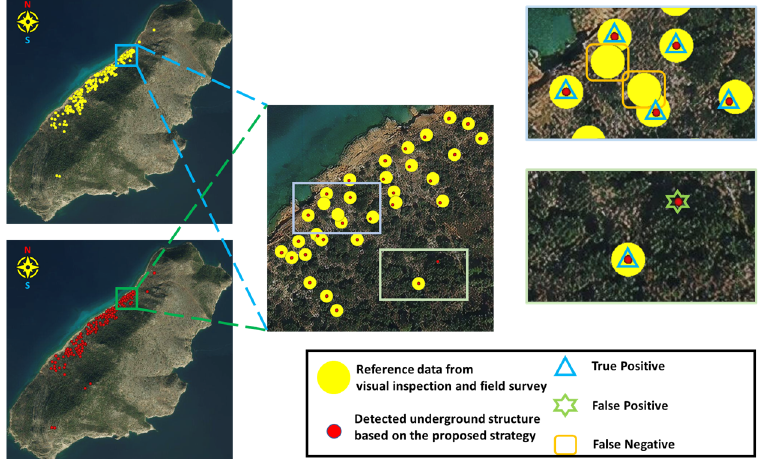
Figure 30. Illustration of detected underground structures and those existing in the reference dataset.